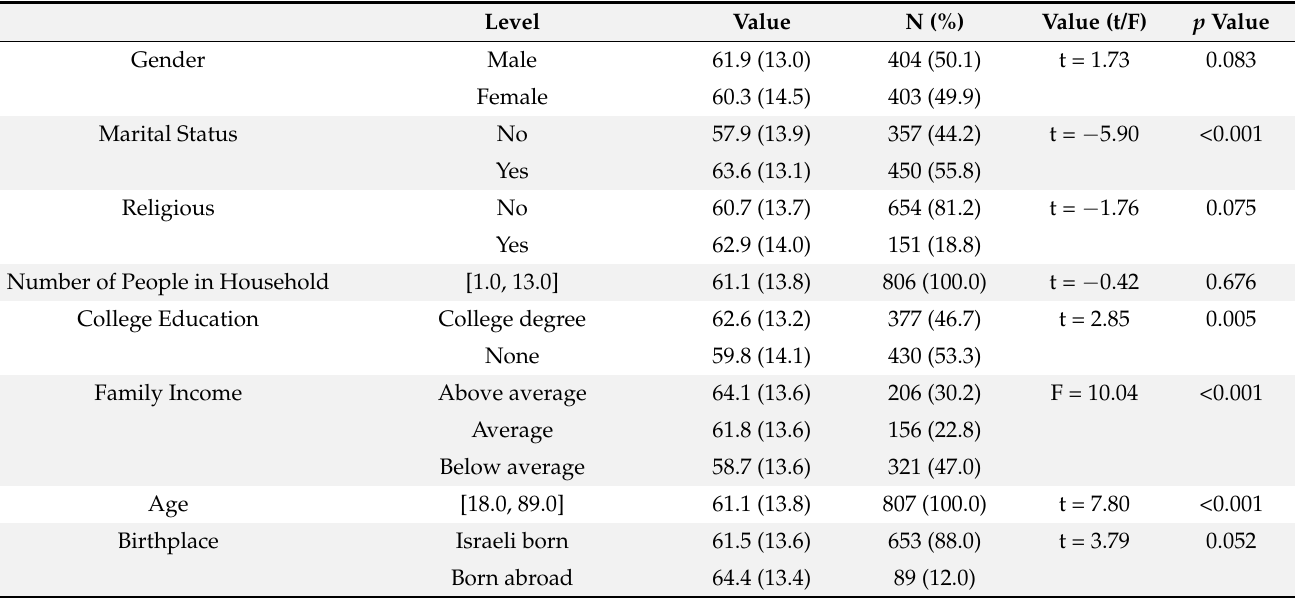
Table 3. Demographic characteristics associated with sense of